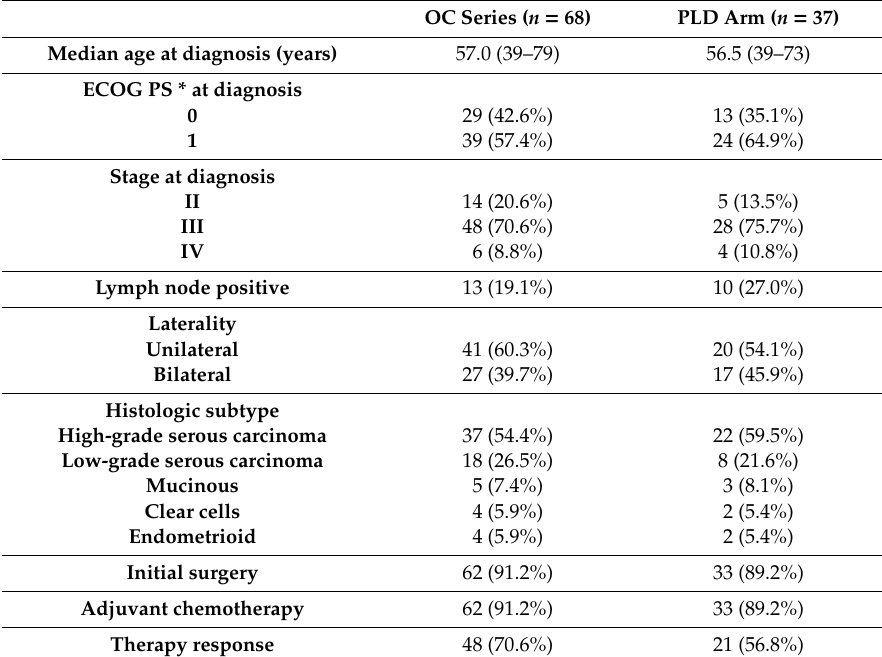
Table 2. Summary of ovarian cancer (OC) patients’ clinical